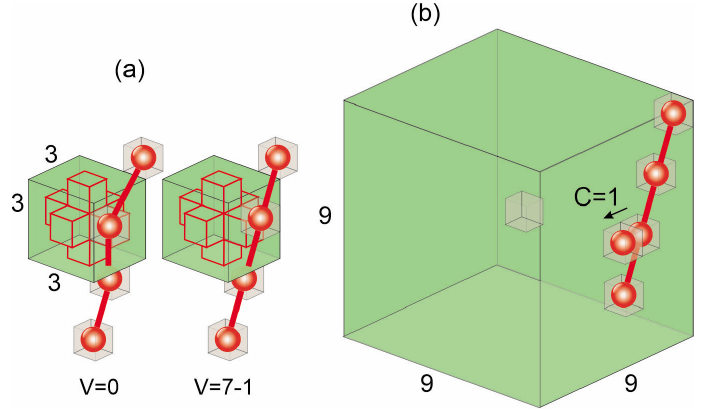
Figure 4. Scheme for calculation of local parameters V ( a ) and C ( b )—see text for more details. Based on